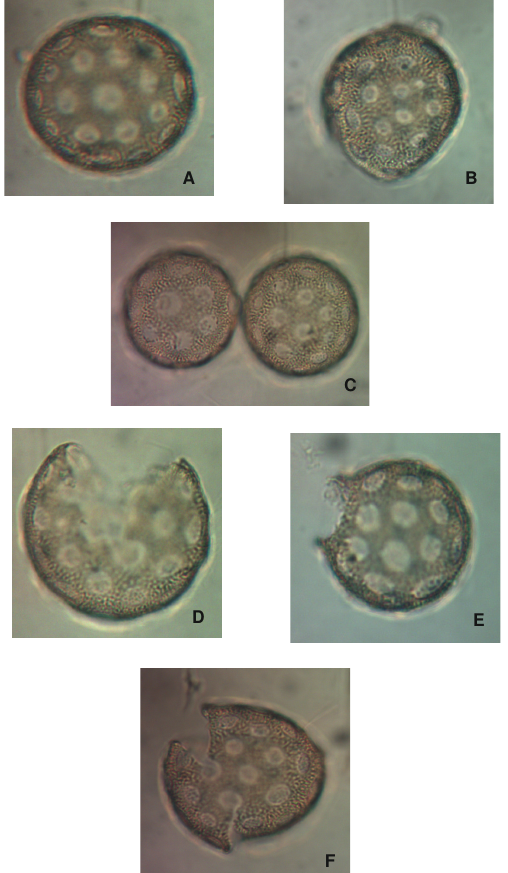
Fig. 7. Pollen grains of T. triangulare pink and white petal F1 hybrid (×400) A & B. Acolpate, C. Dyad pollens, D & E. Monocolpate, F.